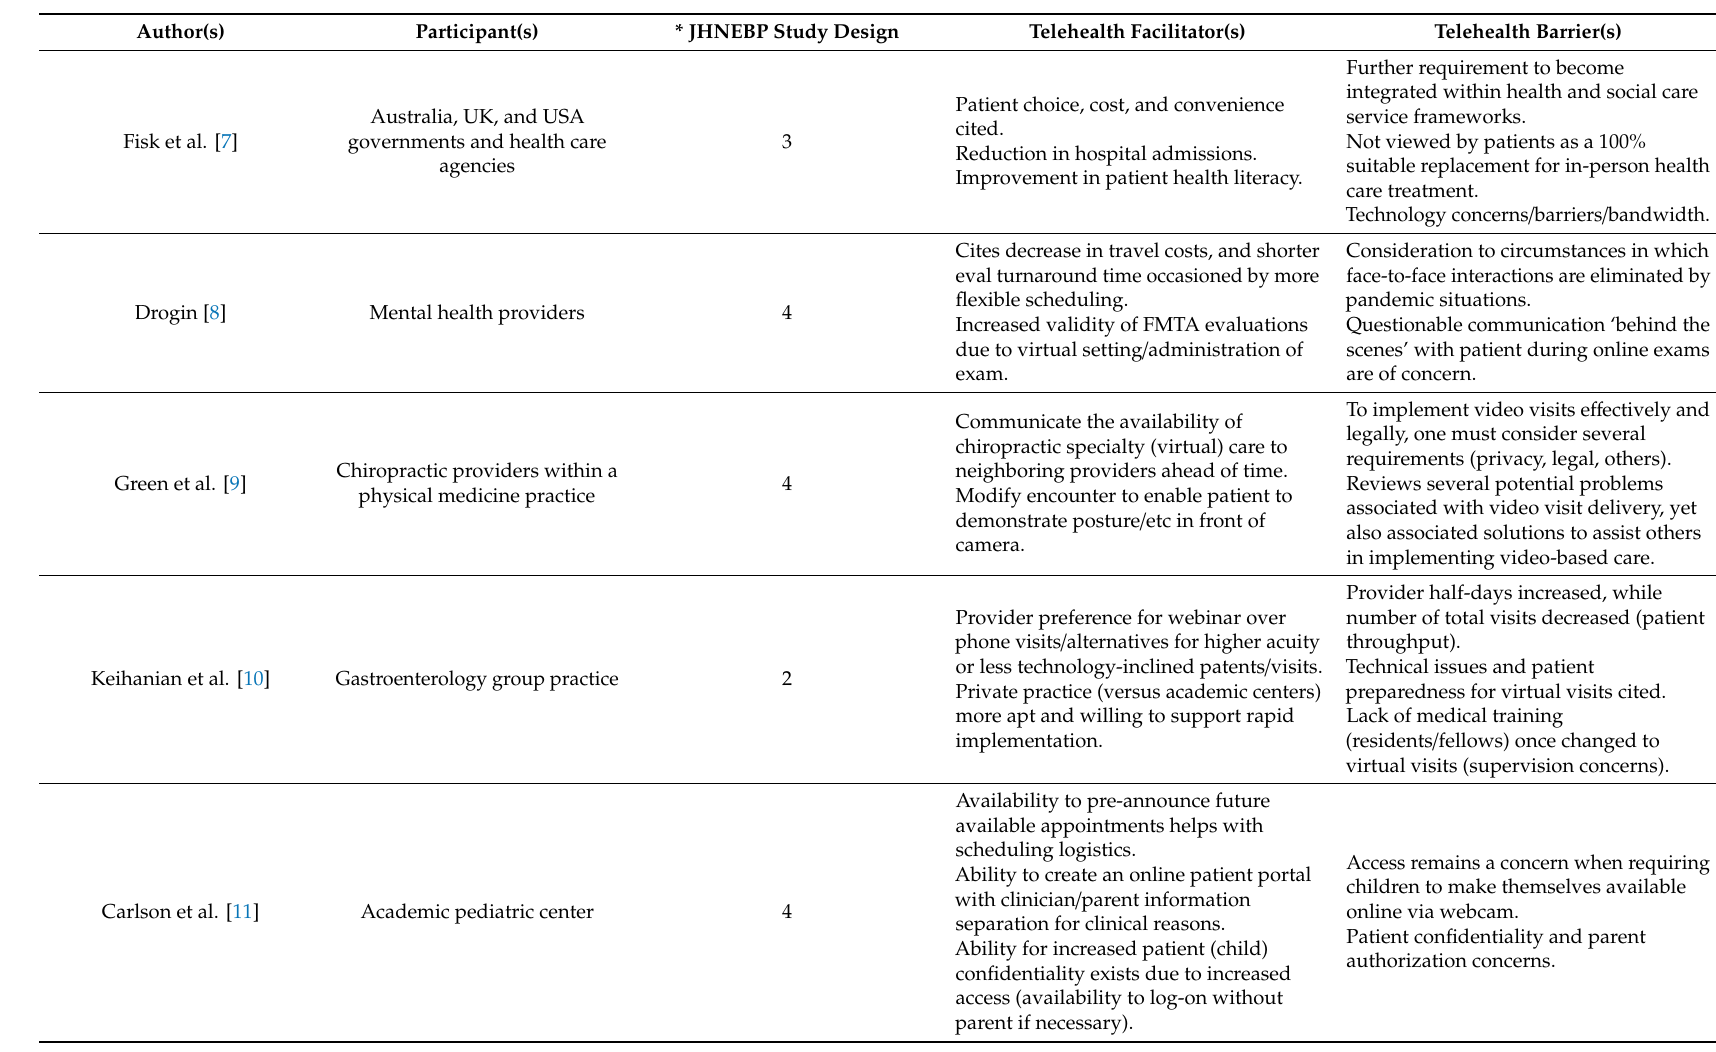
Table 2. Summary of findings ( n =